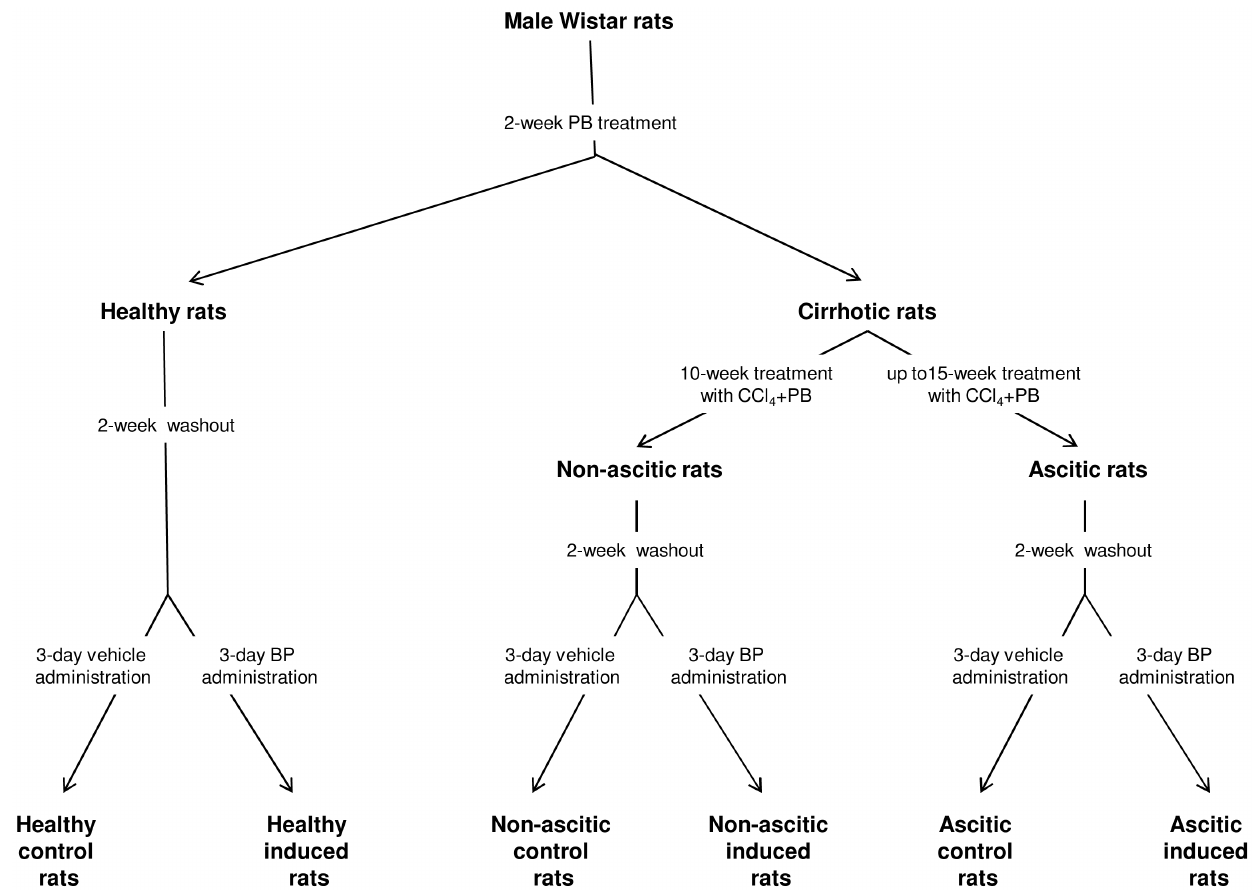
Figure 1. Study design. PB: Phenobarbital; BP: benzo[a]pyrene.